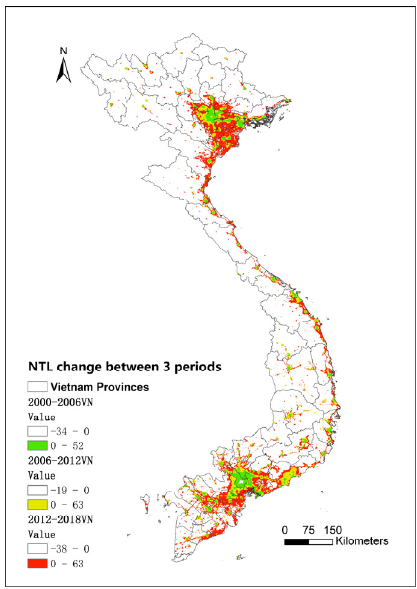
Figure 3. NTL value changes in three periods in Vietnam from 2000 to